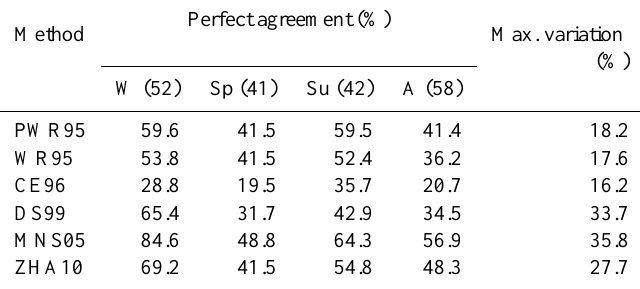
Table 5. Seasonal values of perfect agreement (in parentheses, the total number of cases) and its maximum difference for each method (W: winter. Sp: spring. Su: summer. A: